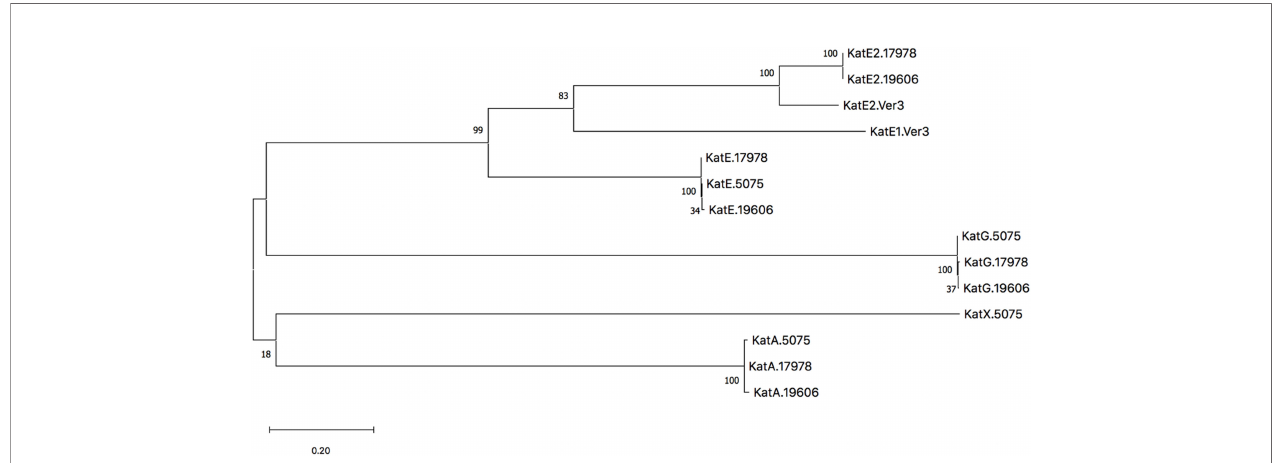
FIGURE 2 | Phylogenetic tree of catalases from A. baumannii strains ATCC 17978, ATCC 19606 T , AB5075, and Acinetobacter sp. Ver3. The dendrogram was constructed with mega version X using the Maximum Likelihood method based on an initial tree constructed from the Neighbor Joining method, and the robustness of the major branching points is indicated by the bootstrap values (800 repetitions). The tree with the highest log likelihood is shown and branch lengths are measured in the number of substitutions per site.